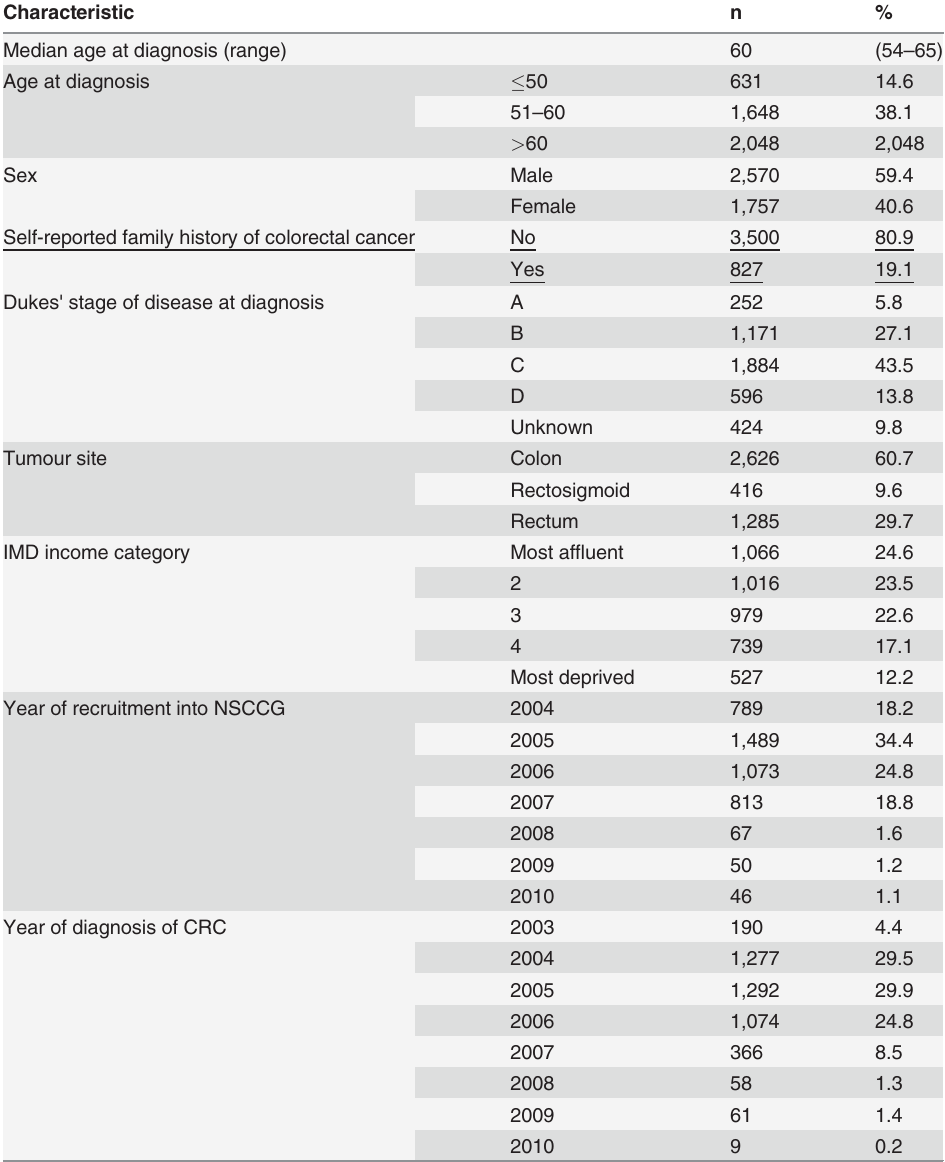
A significant association were identified between rs4444235 genotype and prognosis, where the hazards ratio for increasing number of variant alleles was 1.13 (95% CI: 1.05 – 1.22). Hazard ra- tios for heterozygosity, homozygosity and carrier status were: 1.18 (95% CI: 1.04 – 1.34) and 1.28 (95% CI: 1.11 – 1.48), respectively. It should be noted that the association ( P trend = 0.0015) remained significant if Bonferroni correction for multiple testing was applied ( P adj = 0.032) and remained noteworthy (i.e. FPRP (cid:1) 0.5) provided the prior was > 0.001. Kaplan – Meier esti- mates (Fig. 2) demonstrated that carriers had lower five-year survival than those with the wild- type genotype ( P < 0.01).